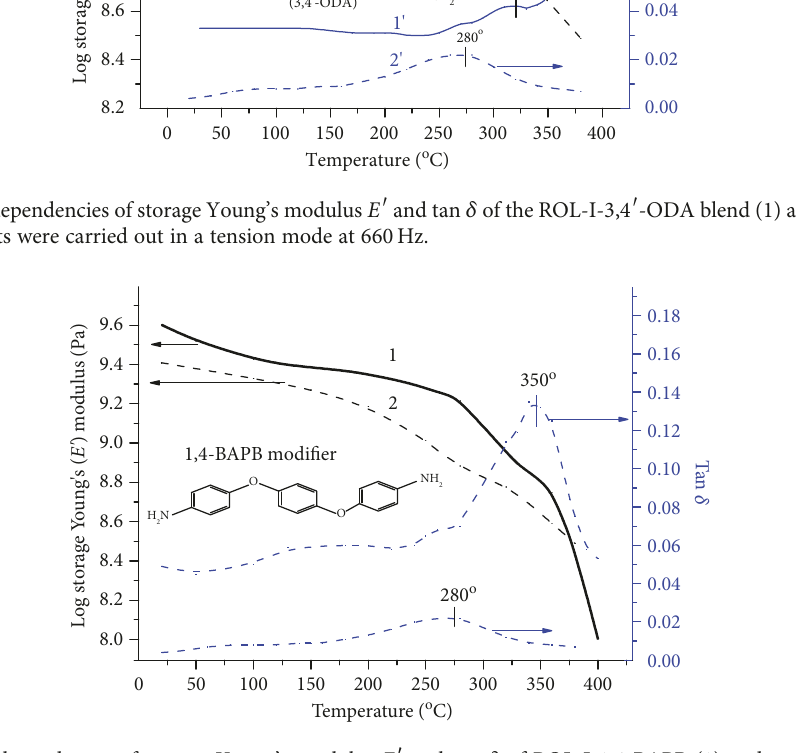
Figure 12: Temperature dependences of storage Young ’ s modulus E ′ and tan δ of ROL-I-1,4-BAPB (1) and neat ROL-I (2). The DMA experiments were carried out at 660Hz in a tension